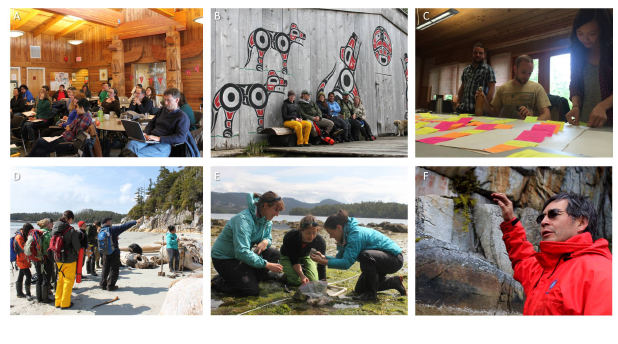
Fig. 2 . Facilitating resilience thinking and practice along